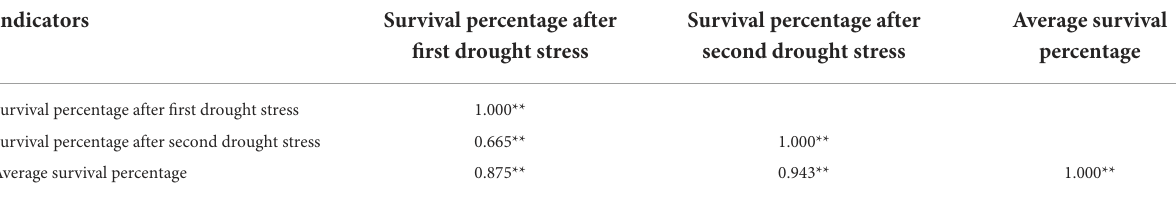
Survival percentage after first drought stress second drought